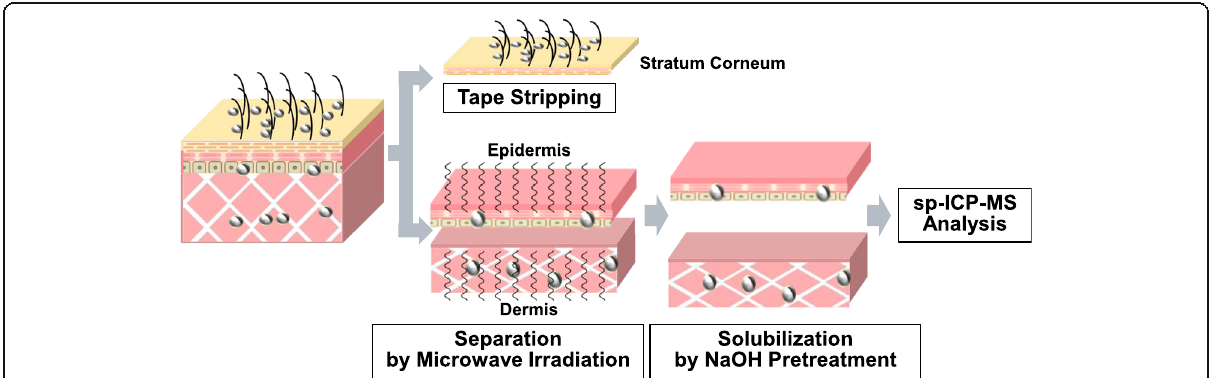
Fig. 1 Strategy to determine the quantity and physical properties of nAg100 in each layer of skin tissue. In order to determine the quantity and physical properties of nAg100 in each layer of skin tissue it is necessary to (1) completely solubilize skin tissues and (2) separate the skin into epidermal and dermal tissues, without tissue loss during recovery or changes in the physical properties of nAg100. In this respect, we focused on (1) NaOH pretreatment and (2) microwave